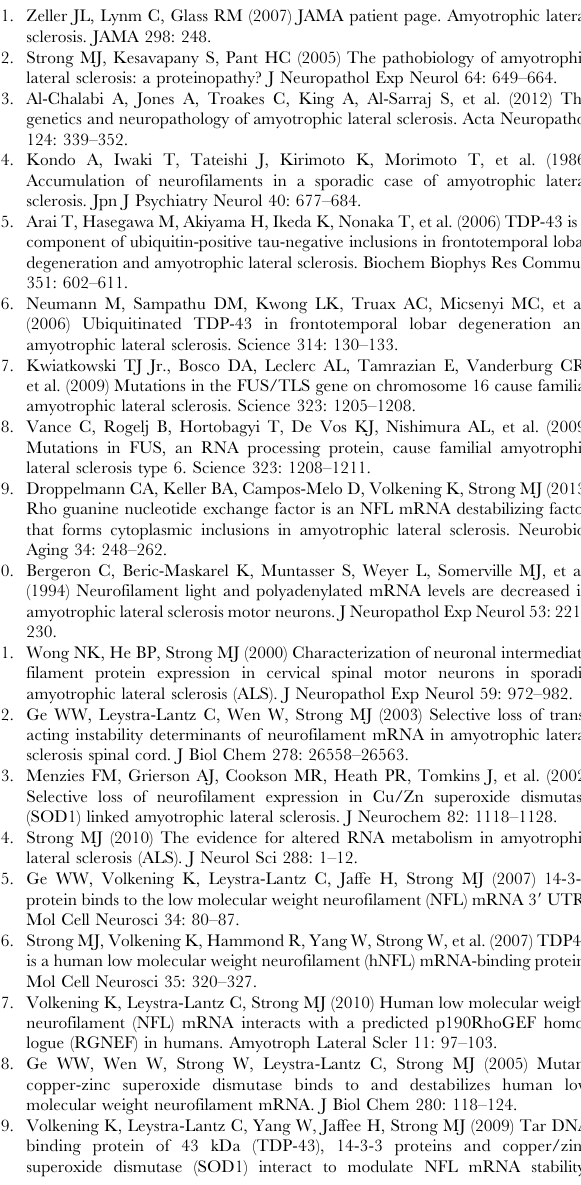
Figure S1 Composition of the libraries.